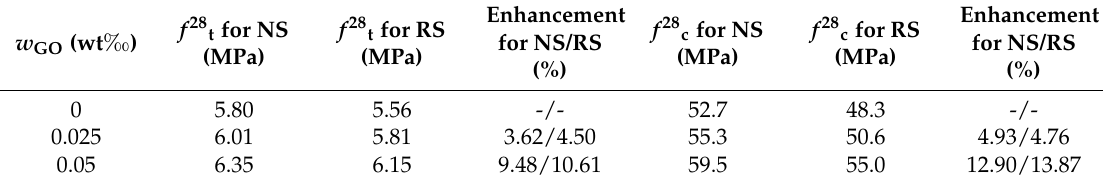
Table 6. Mechanical strengths of six groups of GONM and GO-modified RS-based mortar (GORM) specimens.